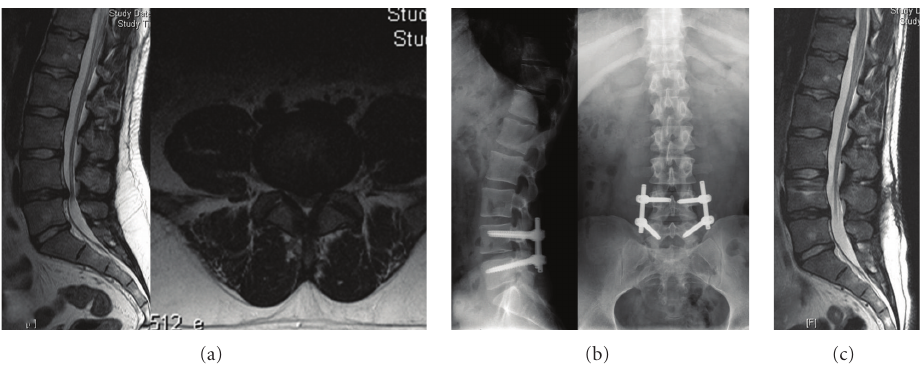
Figure 11: 24-year-old male university student, with acute attacks of low back pain (2–4 times per year). He experienced right leg pain in a sciatalgia form, accompanied by severe low back pain in the last attack. In his neurological examination, he had L5 hypoesthesia but no motor deficit. (a) T2 weighted MRI scans show l4-5 disc herniation; (b) cosmic was applied; (c) the patient was in very good condition, and T2 weighted MRI scan shows a nearly normal appearance after one year.